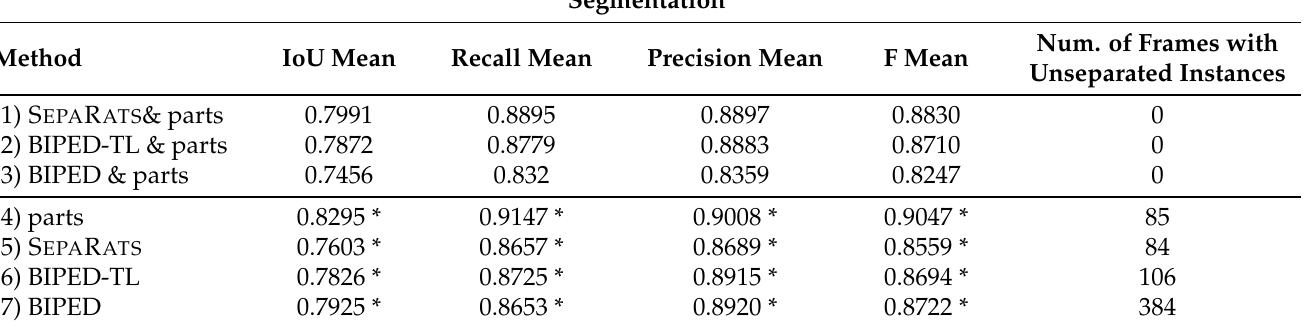
Table 4. Comparison of per-frame segmentation on the 471 frames with occluding instances. In lines (1), (2), and (3) we present the results for the combined segmentation method with both modules: Edge Detection and body parts regions. In (4), (5), (6), and (7) we show the quality of the segmentation for the modules separately. These values are marked by * to indicate that evaluation is only performed for the frames where two different foreground labels were predicted. Right-most column: number of dropped frames for the different